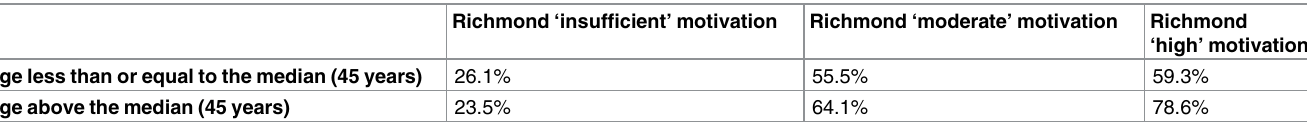
Table 4. Frequency of abstinence according to age and the Richmond test at the initial consultation.